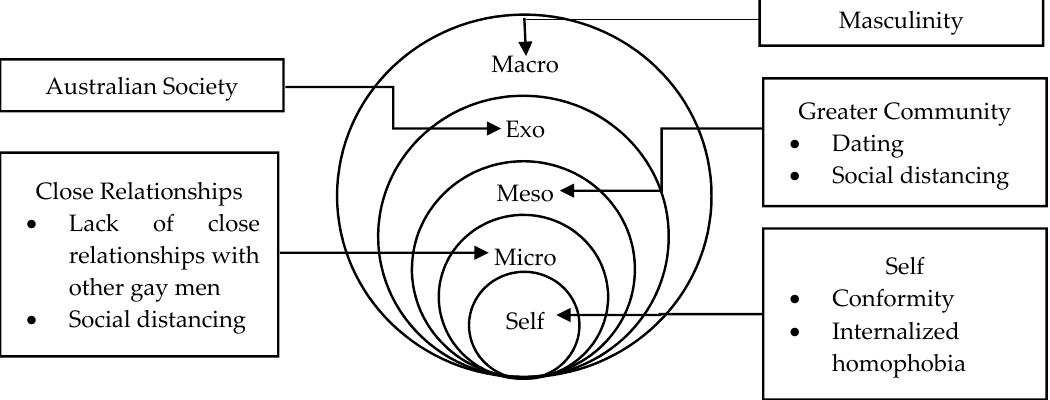
Figure 2. Socio-ecological map of a gay man.